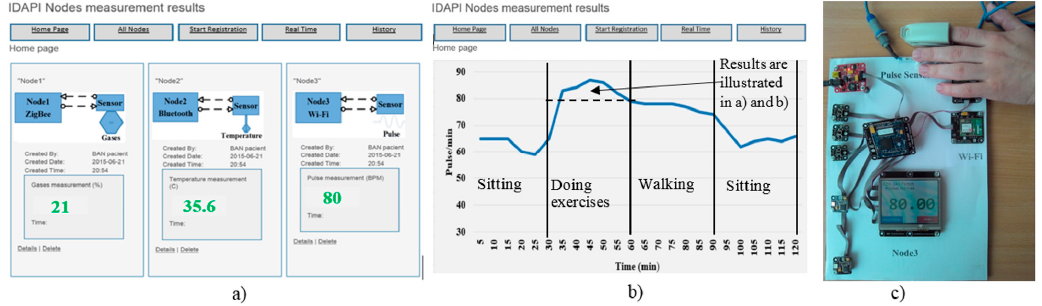
Figure 6. The views: ( a ) real time measurements (both on the patient’s side) and ( b ) the pulse signal history for monitoring over the Internet in the remote station; ( c ) the implemented hardware of the pulse sensor.